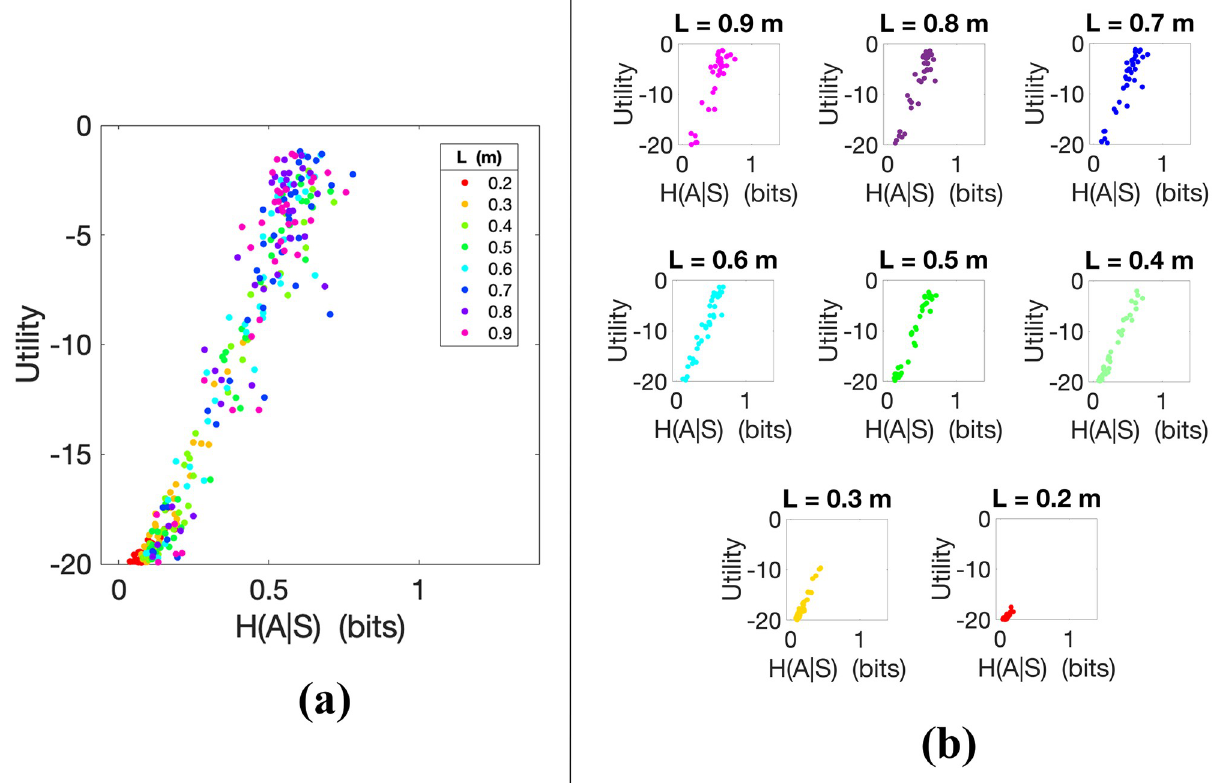
Fig 2. (a) Utility U i of trials i during the balancing task plotted as a function of H ( A i | S i ) for all participants and pendulum lengths L . Larger values of utility U i correspond to better performance in balancing the pendulum. Spearman correlation ρ = 0.944; Pearson correlation r = 0.967. In (b) the trials are separated by pendulum length in different subplots.